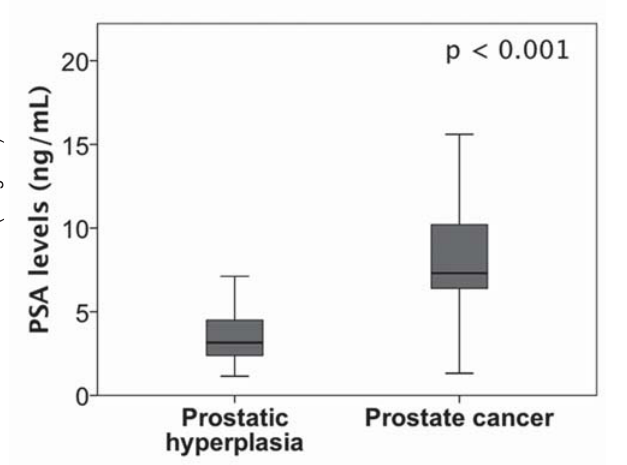
Figure 2 - Serum IGFBP-3 levels (at the inclusion in the study) in patients with prostatic hyperplasia and prostate cancer. Statistical significance was determined by Mann- Whitney’s test. The lower and upper bars represent the first and third quartiles respectively. The line across the box represents median value. The lines above and below the box represent the highest and lowest values, excluding outliers.